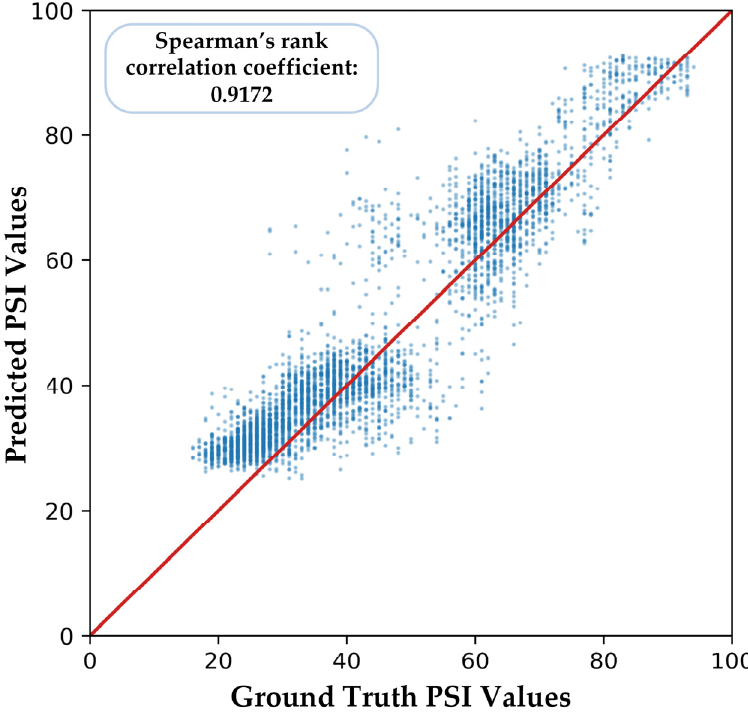
Figure 12. Part of the predicted PSI values of our proposed model in cross-subject validation.